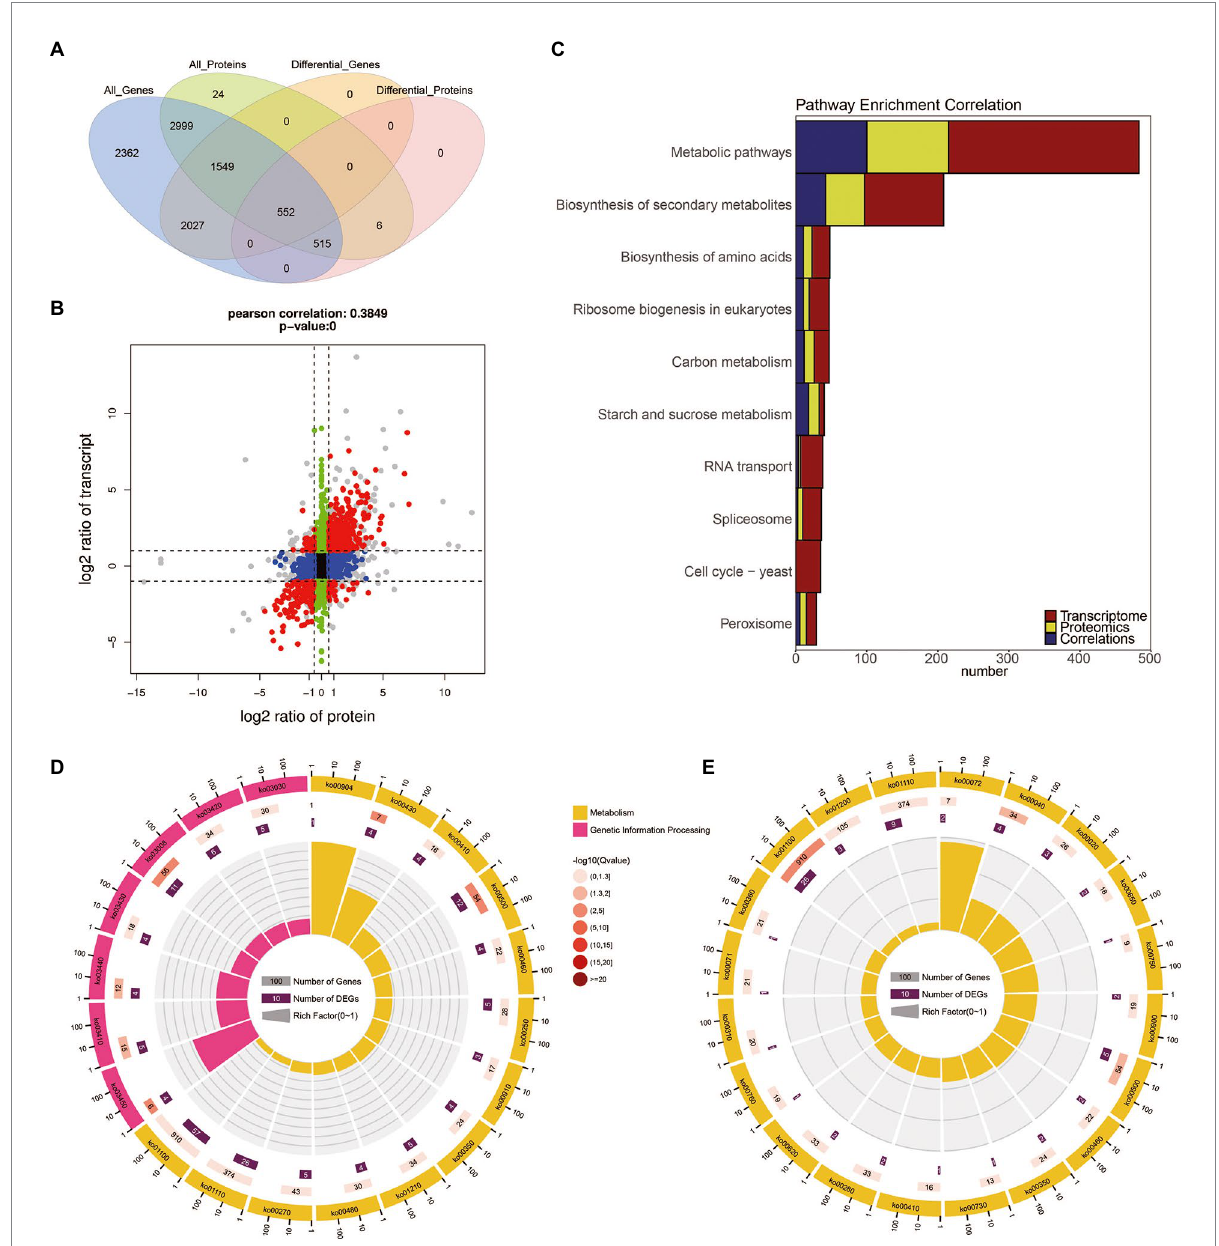
FIGURE 4 The correlation of transcriptome and proteome between the B. cinerea TB-31 and Δ Bcfrp1. (A) Venn diagram of the number of all mRNAs and proteins between TB-31 and Δ Bcfrp1. (B) The nine-quadrant graph of TB-31 and Δ Bcfrp1 (considering the statistical significance, p). [The abscissa is the fold change of the protein (take ratio > 1.5), the ordinate is the fold change of the transcription (take ratio > 2), and at the top of the figure is the Pearson correlation and statistical significance, p, associated with the transcription and proteomic data. Each dot represents a gene/protein: the black dots represent non-different proteins and genes, and the red dots represent the same or opposite trend of changes in genes and proteins, and the gray dots indicate the differential expression of genes but non-differential expression of proteins]. (C) Histogram of the number of genes on the pathway overlapped by TB-31 and Δ Bcfrp1 [The number of differentially expressed mRNA (red), protein (yellow), and associated genes (blue) is annotated on the pathway, respectively]. (D) The circular plot of the pathway overlapped in the quadrant 3 of the nine-quadrant map between TB-31 and Δ Bcfrp1. (E) The circular plot of the pathway overlapped in the quadrant 7 of the nine-quadrant map between TB-31 and Δ